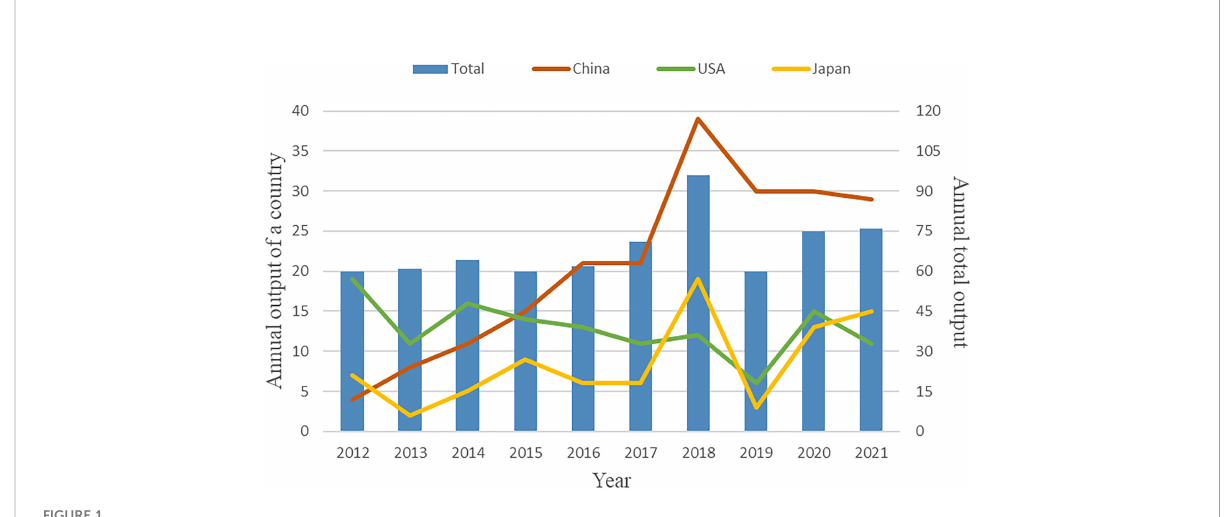
FIGURE 1 The number of annual